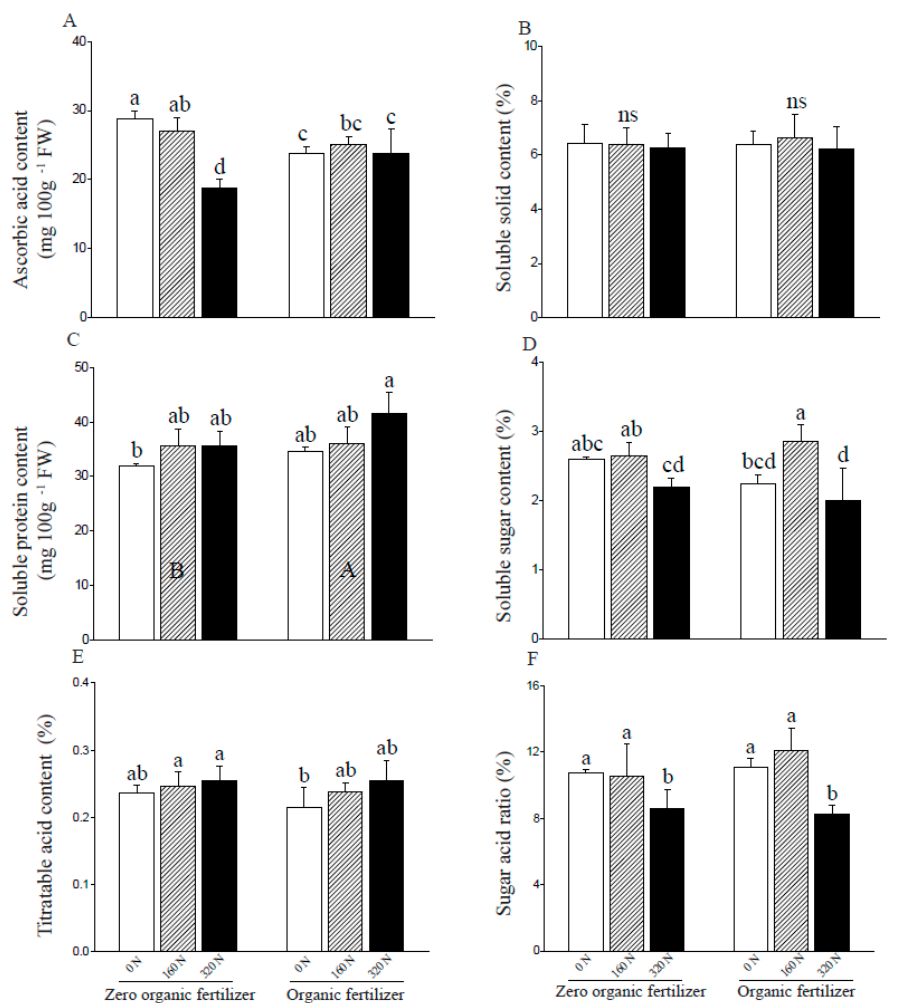
Figure 3. The comparisons of ascorbic acid ( A ), soluble solid ( B ), soluble protein ( C ), soluble sugar ( D ), titratable acid ( E ), and sugar-acid ratio ( F ) of cherry tomato between the three N rates (0, 160 and 320 kg N ha − 1 ) and under the two chicken manure rates during the 2021–2022 growth season. Vertical bars above the mean values indicate standard error. Means with different lower-case letters show significant differences between six combination treatments among the three N application rates under and the two chicken manure doses according to the least significant difference method (LSD 0.05 ). Means with different capital alphabetical letters show significant differences between the two chicken manure rates according to the least significant difference method (LSD 0.05 ). Under chicken manure application condition, there was no significant difference in all fruit quality traits between the two N application rates (0 and 160 kg N ha − 1 ) during the second growth season (2021–2022). However, N application at a rate of 320 kg N ha − 1 exhibited a significant and negative effect on soluble sugar and sugar-acid ratio. For example, the highest N application rate (320 kg N ha − 1 ) significantly decreased soluble sugar by 11% compared to zero N rate, which resulted in a lower rate of sugar-acid ratio. Conversely, compared to zero N rate, the highest N rate (320 kg N ha − 1 ) exhibited a positive effect on soluble protein content which was significantly increased by 20% (Figure 3). In addition, compared to the zero-chicken manure treatment, application of chicken waste significantly increased the soluble protein content in the 2021–2022 growth